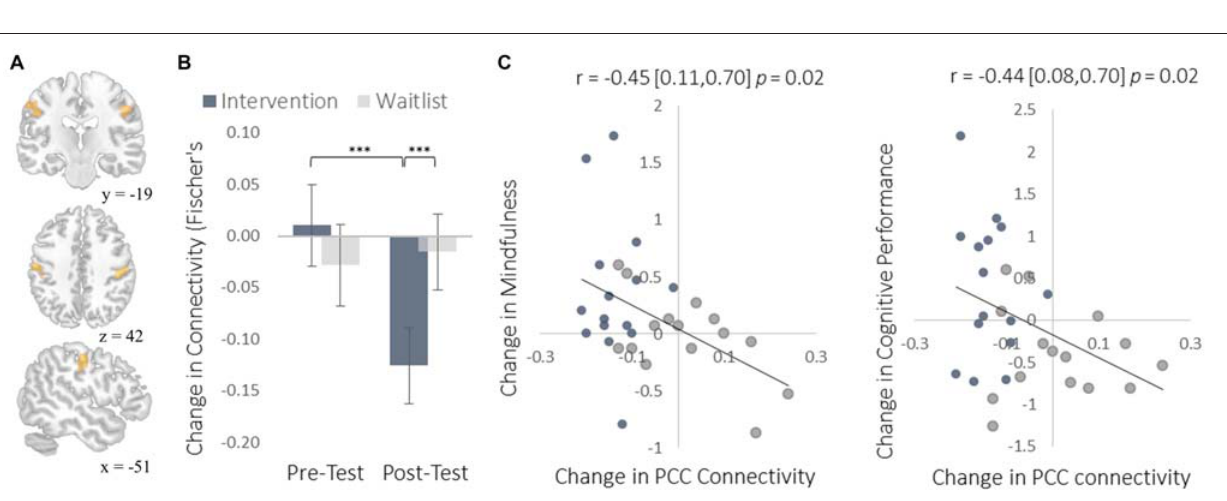
FIGURE 7 | Results for somatosensory cortex (S1) regions showing a decrease in functional connectivity with the PCC seed regions of interest (ROIs). (A) The location of S1 functional connectivity changes, comprised of bilateral S1 clusters; left-hemisphere cluster MNI peak-coordinate: ( − 52, − 16, 40); right-hemisphere cluster MNI peak-coordinate: (50, − 18, 38). Subsequent reports integrate these two regions into one set of S1 regions by computing the mean functional connectivity value across all voxels within both clusters. (B) Mean Fisher r -to- z transformed functional connectivity values. (C) Scatterplots correlating changes in PCC-S1 functional connectivity with changes in mindfulness and changes in cognitive performance from pre-testing to post-testing. Error bars and brackets represent 95% confidence intervals. ∗∗∗ p < 0.001. N = 30.